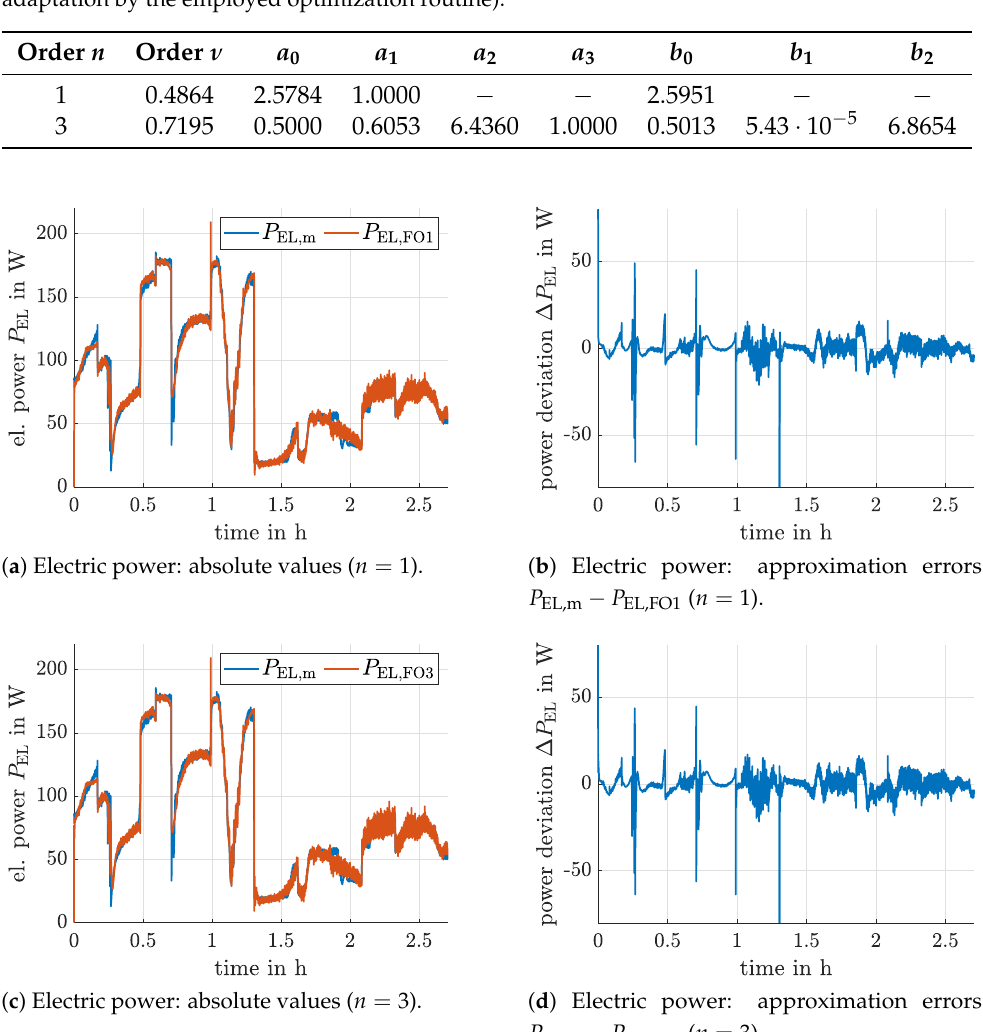
(cid:54) = 1 indicates a static gain a 0